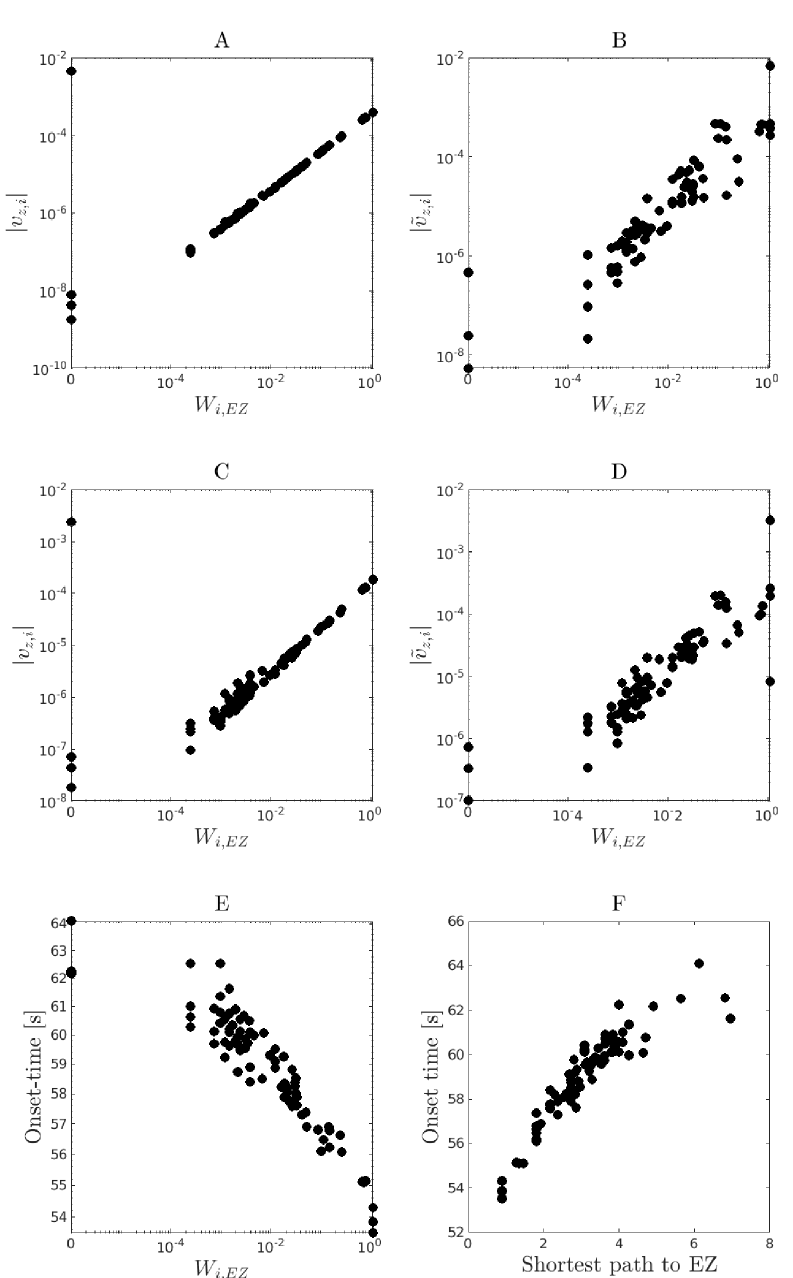
Fig 6. Relationship between the magnitude of the leading eigenvector components and the patient-specific | are plotted versus the interaction connectivity matrix. The magnitudes of the leading eigenvector components | v z , i weight W i , EZ from the EZ area to the corresponding i th surrounding node. As before, v z , i indicates the eigenvector component related to the permitivity variable z in the i th node. (A,B) panels are based on the 2D-reduced epileptor network model with the active EZ node included ( A ) or replaced by a constant input ( B ). (C,D) Similarly, but for the original epileptor network model. E Relationship between the seizure onset times for each network nodes and the corresponding interaction weight ( W ) from a given active EZ node. F Similarly, but with respect to the shortest path i , EZ between a given surrounding node and the corresponding active EZ node. The panels show an example from a single stochastic realization from patient-specific network P1, with node 64 as the active EZ ( x 0 = − 1.6), surrounding node excitability set to x 0 = − 2.13, global strength connectivity w = 1.1, and noise level with σ = 0.05. The panels show strong relationships among the leading eigenvector components, the patient-specific connectivity, seizure recruitment times, and shortest path length from the active EZ node to surrounding nodes.